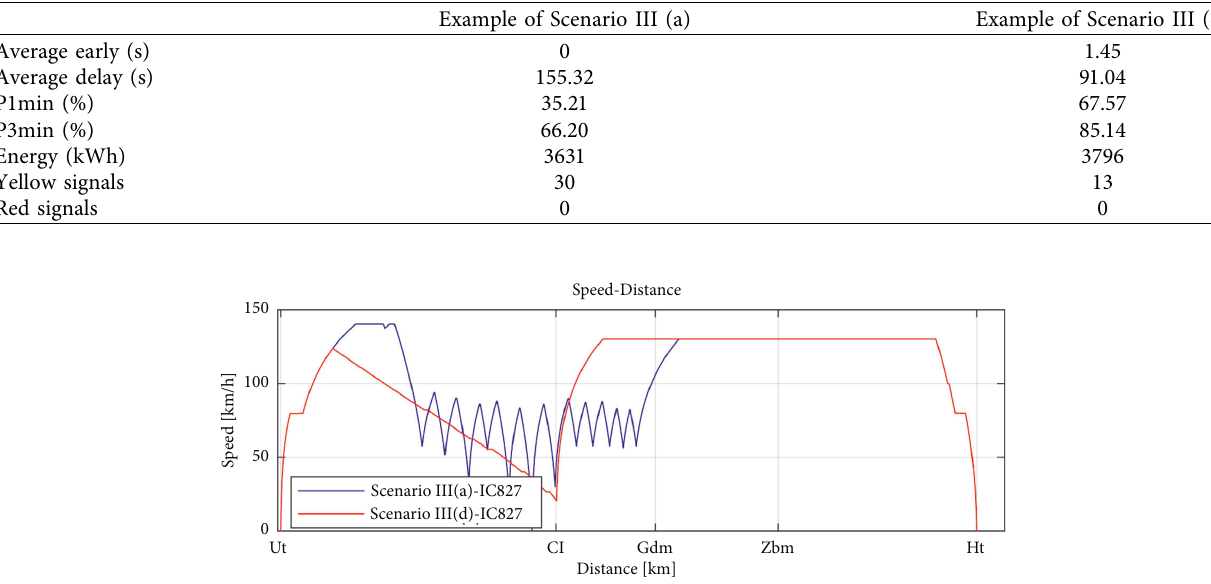
Table 4: Metrics of the examples in Figures 10 and 11.